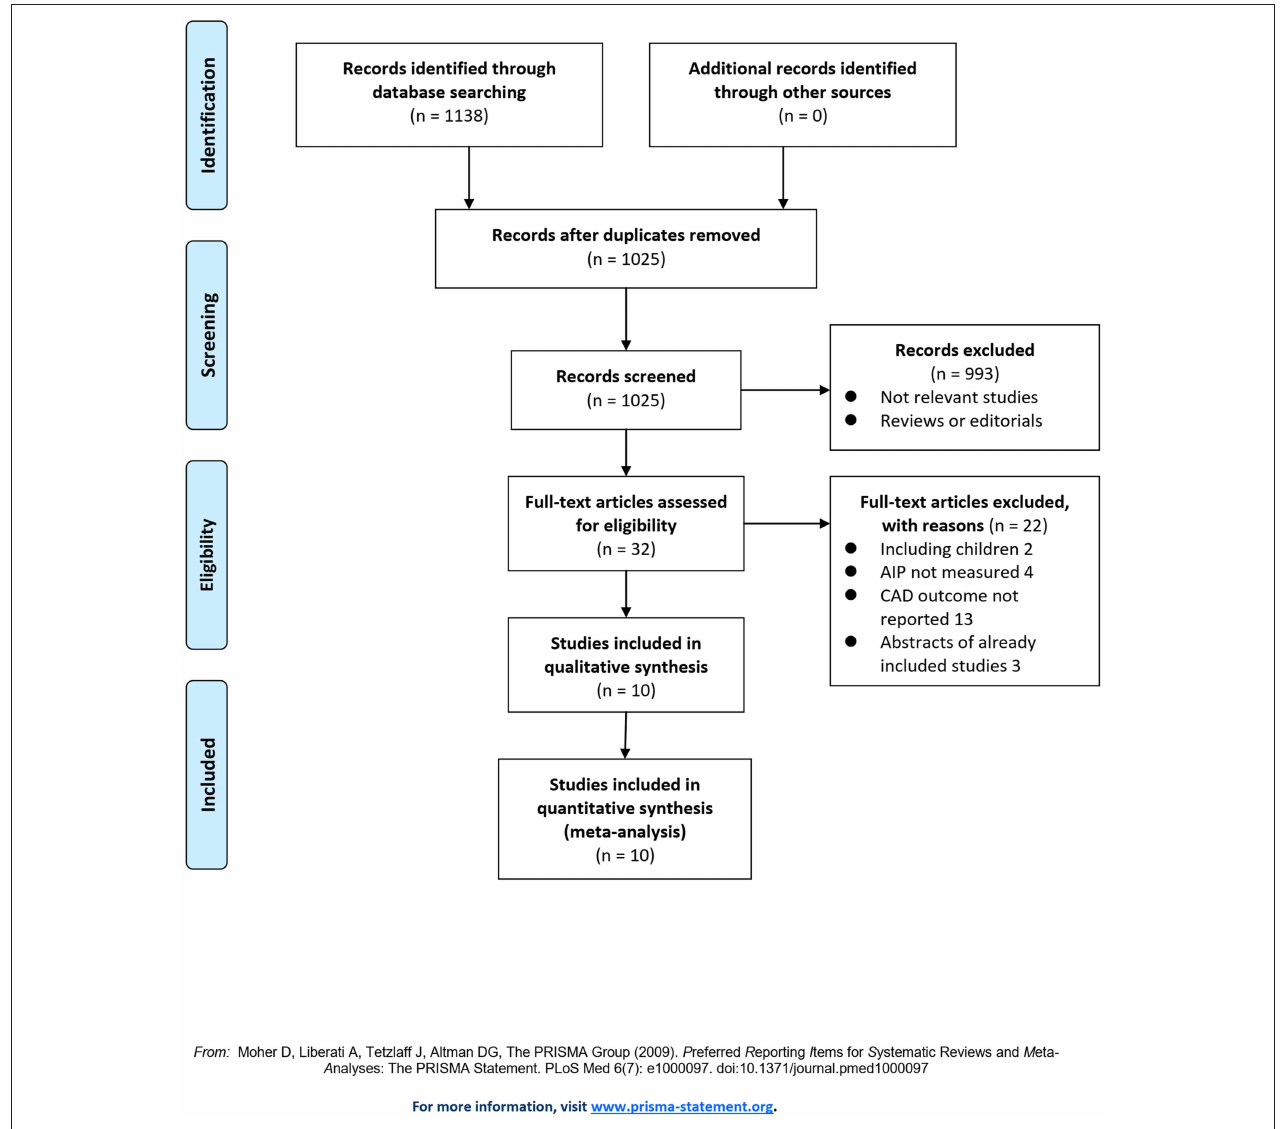
FIGURE 1 | Flowchart of the database search and study identification.